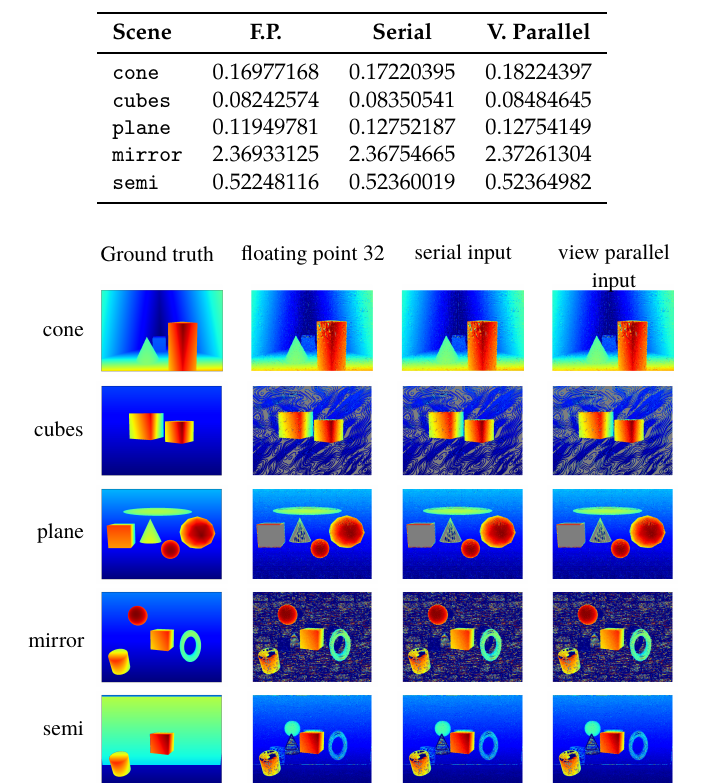
Figure 13. Disparity maps for the test images. Column 1: Ground truth. Column 2: Results with a floating-point implementation. Column 3: Results with serial input hardware. Column 4: Results with parallel input hardware. Warm colours are objects close to camera, while cold colours are objects far from camera. Gray pixels are positions where the algorithm did not provide a valid